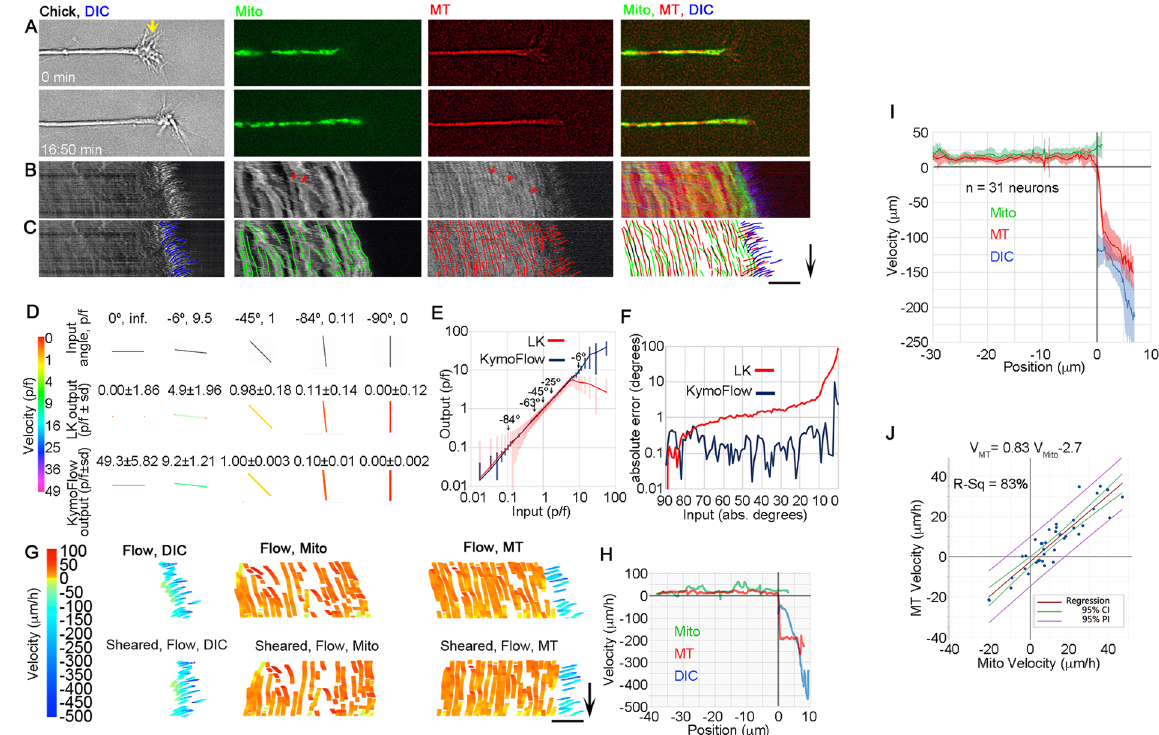
Figure 1. Axonal MTs and docked mitochondria translocate anterogradely during axonal elongation. ( A ) Still images of a chick DRG growth cone at the beginning and end of a time-lapse sequence in DIC, mitochondrial, MT fluorescent channels, and merged channels. Yellow arrow marks the T zone. ( B ) Kymograph showing motion. Red arrows indicate a mitochondrion and MT speckle undergoing fast transport. Scale and time bar as indicated. ( C ) Traces used to measure motion; arrow 10 min and bar 10 μ m. ( D ) Input and output of LKMTA and KymoFlow algorithms for a subset of angles with color coded local velocities. ( E ) Input versus output shown as the average ± sd of velocity in units of p/f. ( F ) Average absolute error in degrees as a function of input angle. ( G ) Raw and sheared KymoFlow maps with color-coded velocities; arrow 10 min and bar 10 μ m. ( H ) Velocity as a function of distance for the shown example. Position 0 corresponds with the growth cone T zone, where retrograde flow transitions into anterograde motion. ( I ) Velocity ± 95% CI as a function of distance for 31 neurons. ( J ) Regression analysis of docked mitochondrial and axonal MT velocity for 31